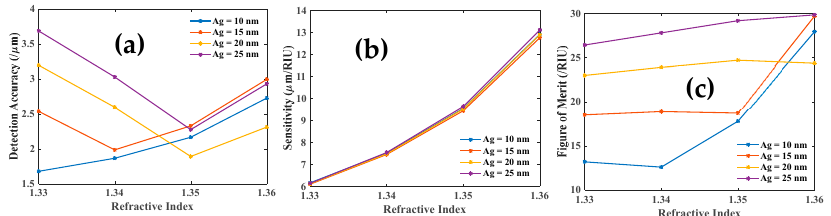
Figure 15. ( a ) DA, ( b ) sensitivity and ( c ) FOM of the SPR dip as a function of RI of the analyte.